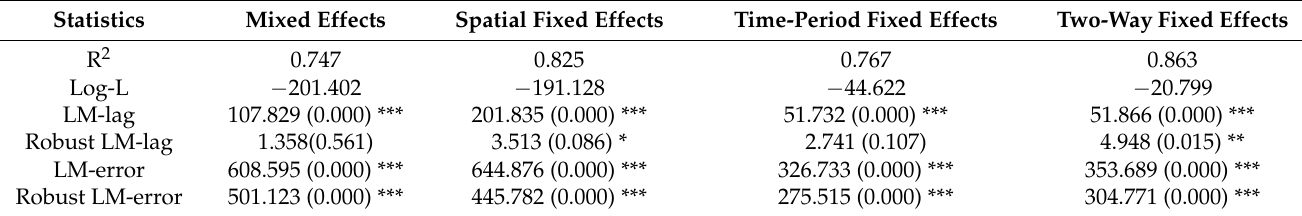
Table 4. LM test results of four forms under the common panel